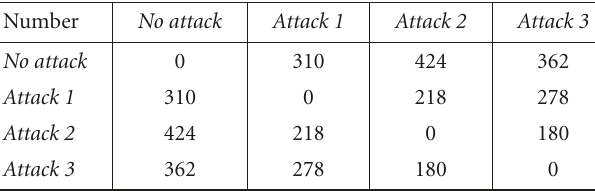
Table 5: Comparing no attack and attack scenarios in bank surveil- lance data. L 1 distance between histograms of parameters of online BMS model is used as similarity score.